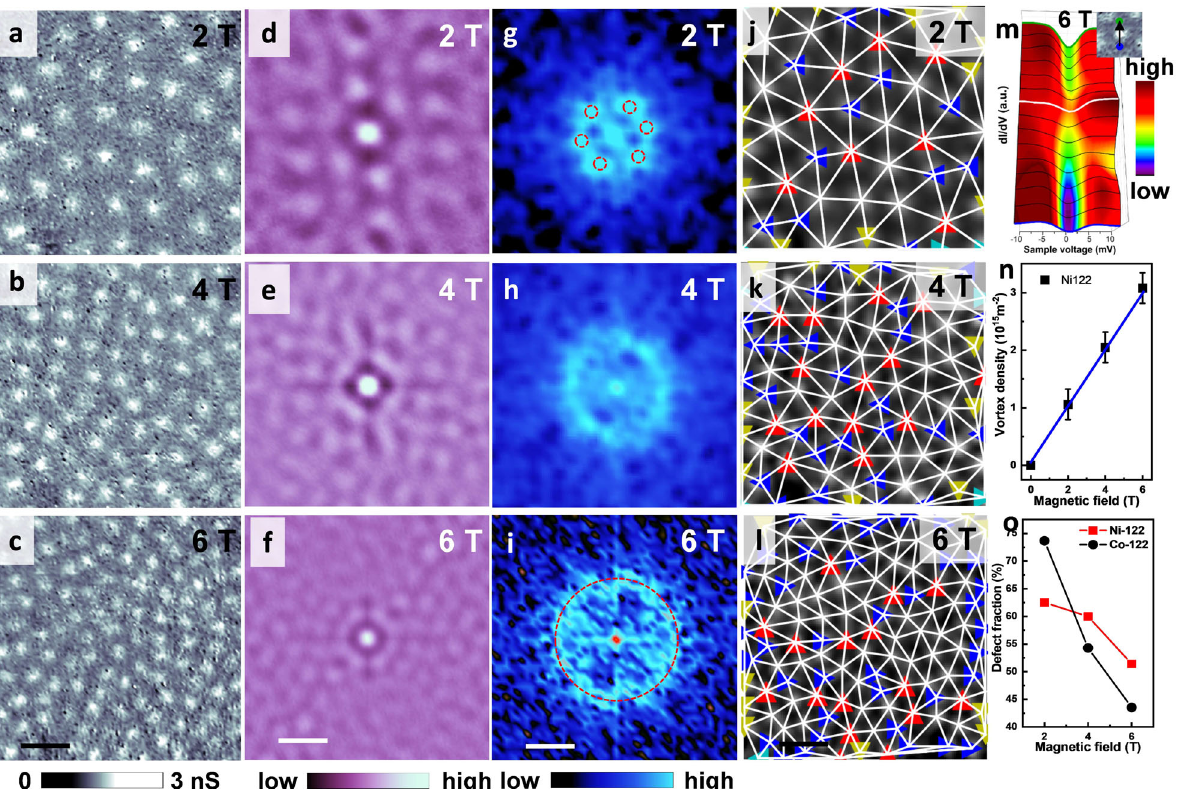
Fig. 4 Vortex imaging in Ni-122. a – c STS maps at E F show the vortex lattices from the same location at the various vertical magnetic fi eld. ( V Bias = − 10 mV, I t = 100 pA and T = 4.2 K). d – f Two-dimensional self-correlation images calculated from vortex images shown in ( a ) – ( c ). g – i The FFT of the vortex images. j , k and l Delaunay triangulation diagrams overlaid on vortex images shown in ( a ) – ( c ). Triangles emphasize the vortices with nearest neighbors different from 6 (cyan: 3; yellow: 4; blue: 5 and red: 7). m Spatial evolution of STS crossing a vortex core center along the black arrow in the inset. The spectra are offset for clarity. n Magnetic fi eld-dependent vortex density in Ni-122, the error bars represent the standard deviation. o The fractions of defect-vortex at different magnetic fi elds for Ni-122 and Co-122, the scale bars represent 40 nm for ( a ) – ( f ), and ( j ) – ( l ), 0.05 nm − 1 for ( g ) – ( i